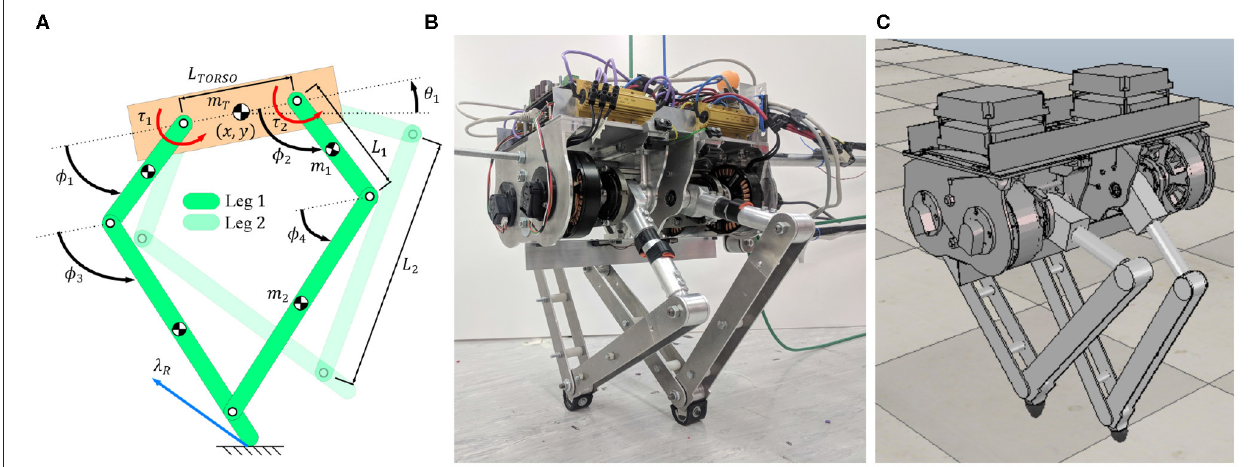
FIGURE 3 | The mathematical model with all the generalized coordinates is shown on the left (A) with the physically built robot in the middle (B) . On the right (C) is the V-Rep simulation of the robot with parameters imported from accurate SolidWorks models. For the mathematical model the position of the COM of the body is represented by x and y , with the pitch angle of the body represented by θ 1 (an absolute angle). The femur’s (top links of the leg) are represented by the relative angles φ 1 and φ 2 with respect to the body. The absolute angles are therefore φ 1 + θ 1 and φ 2 + θ 1 respectfully. The tibia’s (bottom links of the leg) are represented by the relative angles φ 3 and φ 4 with respect to the body, with the absolute angle being φ 3 + θ 1 and φ 4 + θ 1 respectfully. The reason for this angle convention is due to it simplifying the constraints for the trajectory optimization